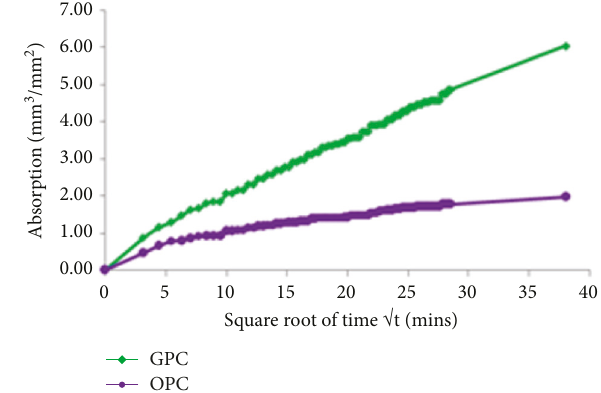
Figure 14: Absorption versus square root of time for GPC and OPC